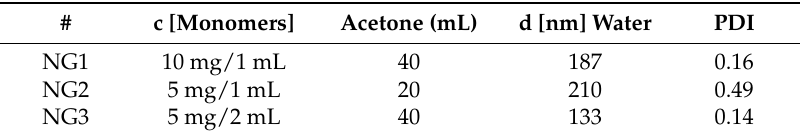
Table 1. PG-DOX NGs prepared at different concentrations of macromonomer solution and volume ratios between solvent and